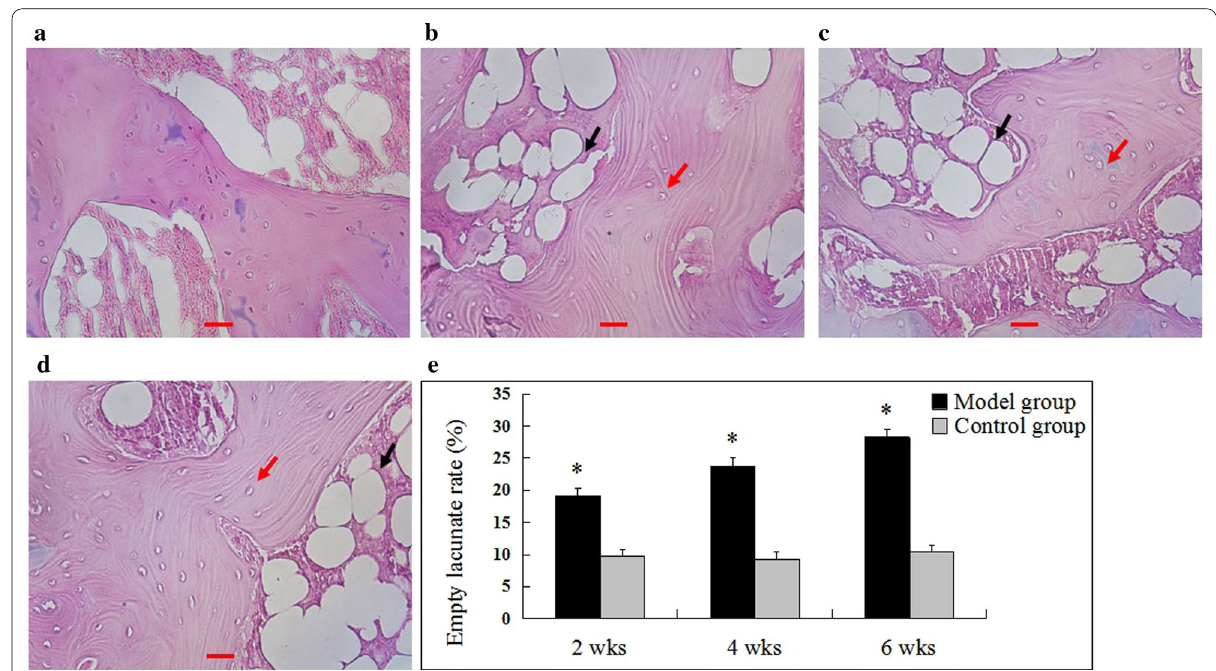
Fig. 3 Histological images in bone tissues in both groups detected via H&E staining ( group ( a ). Typical osteonecrosis of the femoral heads was observed in model group ( b – d ). Scale bar group was significantly higher than that control group at each time point ( e ) (*compared with control group, P < 0.05. The red arrow shows the empty lacunae, and the black arrow shows the fat cells). Model group vs control group: the 2nd week (n week (n 9 vs =